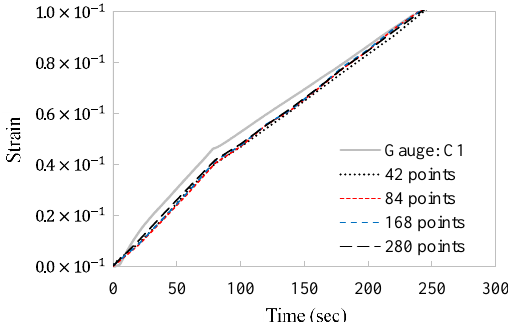
Figure 21. Comparison of the change in strain over time measured in the experiment and the strain value calculated by the synthetic structural analysis.